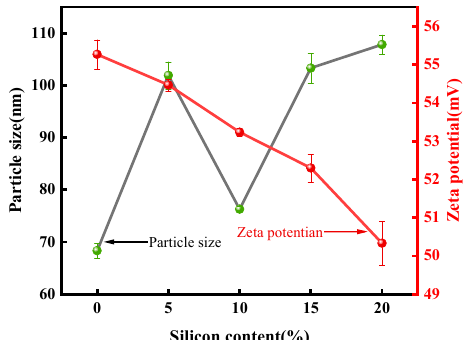
Figure 5. Particle size and zeta potential of SWPUA emulsion with di ff erent silicon content .